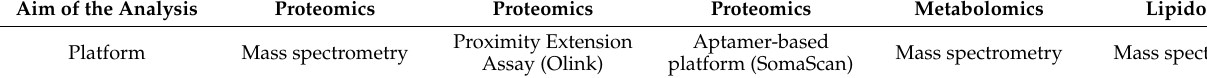
Table 1. Overview of proteomics, LC-MS based metabolomics, and lipidomics